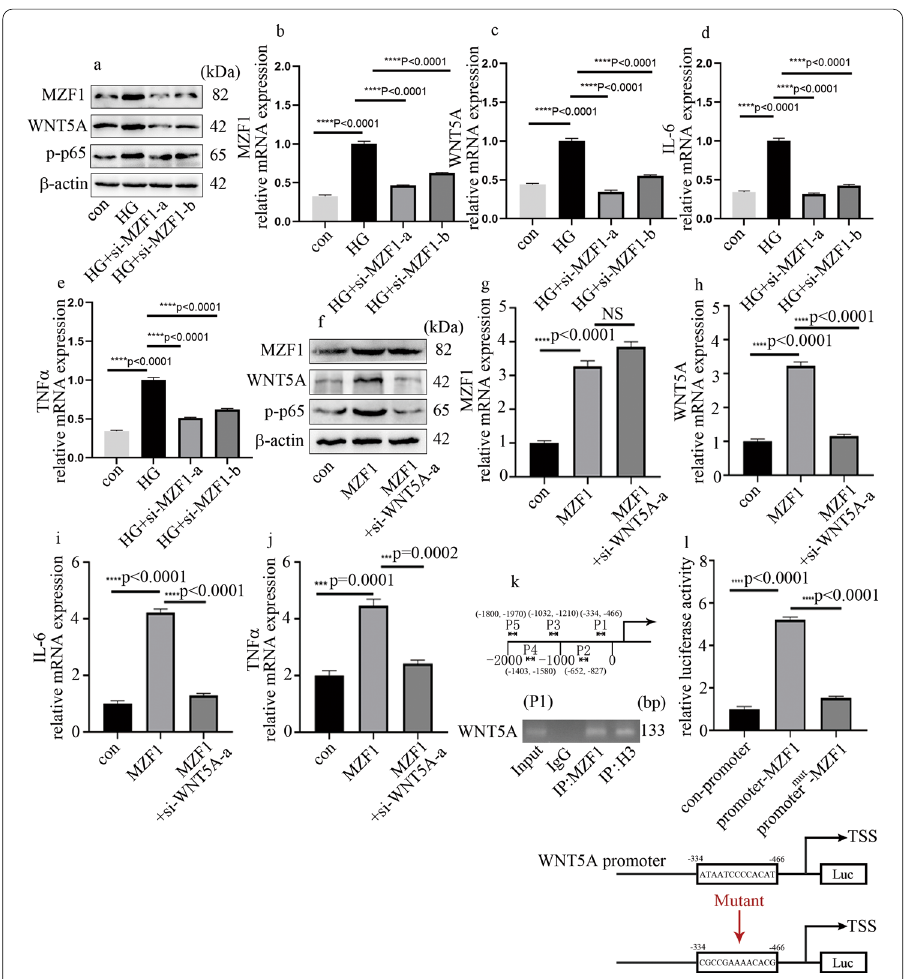
Western blot analysis of MZF1, p-p65, and WNT5A in HGECs. g – j mRNA expression of MZF1, WNT5A, IL-6, and TNFα in HGECs. k MZF1 in promoter region of WNT5A. l Luciferase assays of effect of MZF1 on